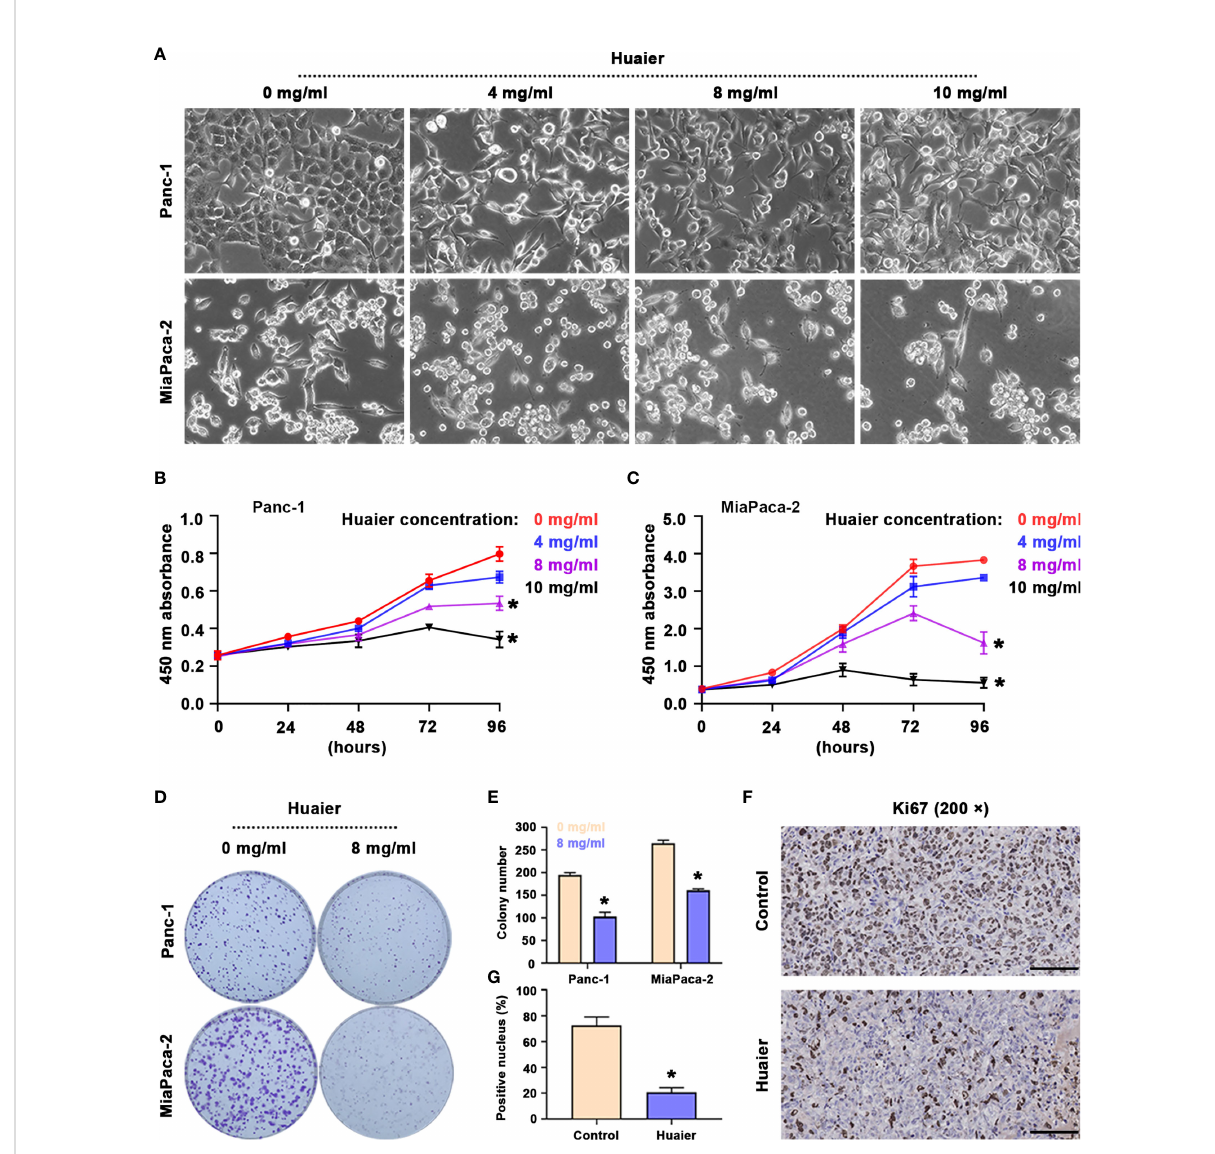
FIGURE 1 Huaier inhibited pancreatic cancer cell proliferation in vitro and tumour growth in vivo . (A) Bright fi eld images showing the cell morphology of Panc-1 and MiaPaCa-2 cells after treatment with various concentrations of Huaier. (B, C) CCK8 assay showing the viability of Panc-1 and MiaPaCa-2 cells after treatment with various concentrations of Huaier for 24 h, 48 h, 72 h, and 96 h. (D, E) Colony formation assay and its statistical analysis showing the cell proliferation of Panc-1 and MiaPaCa-2 cells after Huaier treatments for 2 weeks. (F, G) IHC staining of Ki67 and its statistical analysis showing the proliferation status of pancreatic cancer tumours in the control and Huaier groups. *P < 0.05, scale bar = 100 m